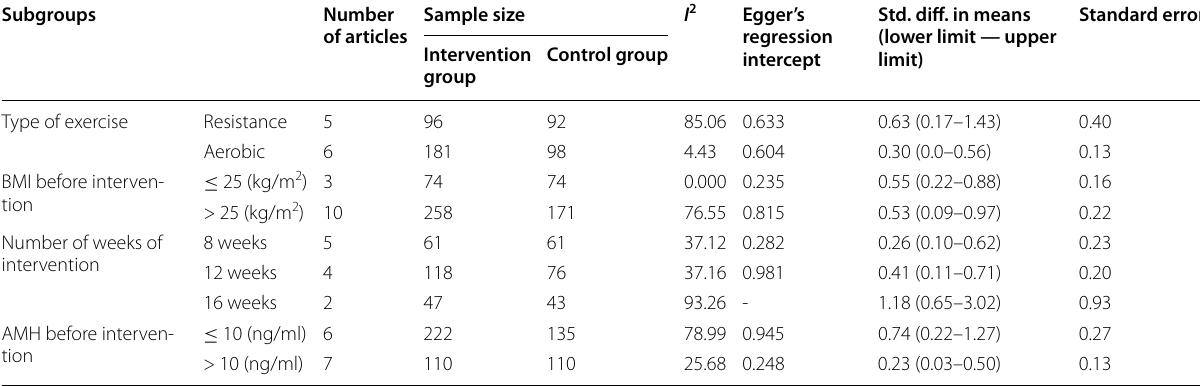
Table 4 Subgroup analysis of the included studies according to type of exercise, BMI, number of weeks of intervention, and AMH Subgroups Number Sample of articles